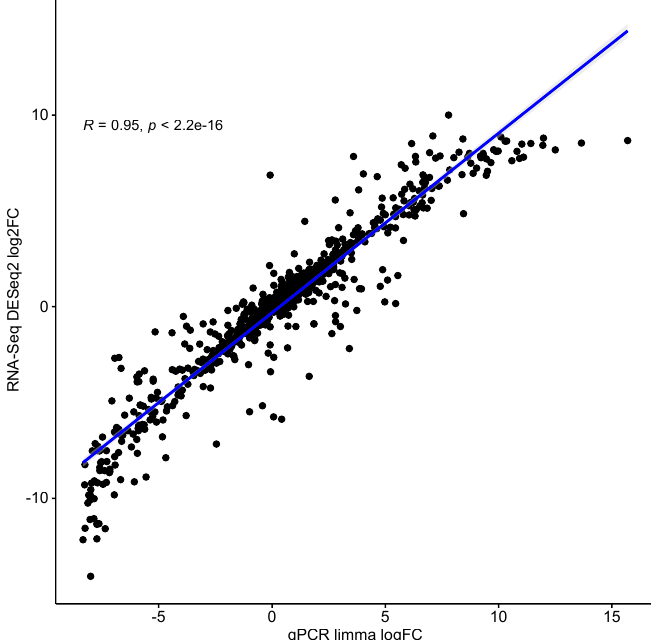
Figure A3. Logarithmized fold change correlation between limma results of qRT-PCR and pipeline results ( DESeq2 ) of RNA-Seq data filtered by adjusted p -value ≤ 0.005 of limma results. The correlation was calculated by the Pearson coefficient.